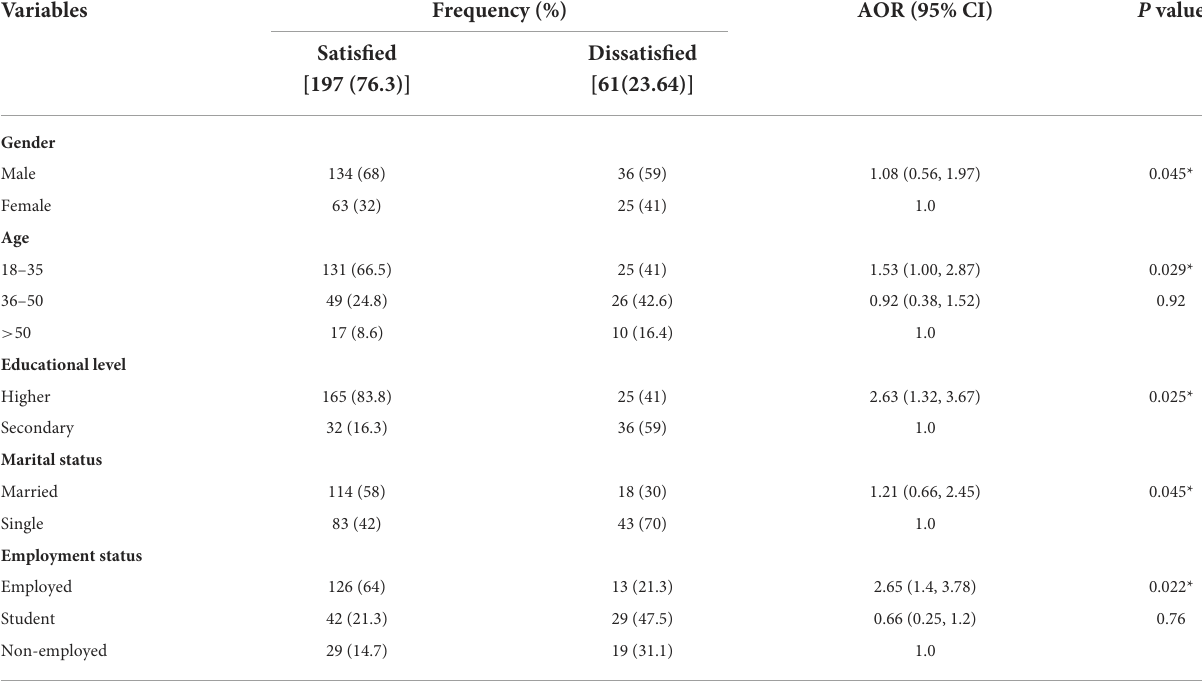
TABLE 4 Logistic regression analysis of factors influencing patients’ satisfaction on nursing services ( n =